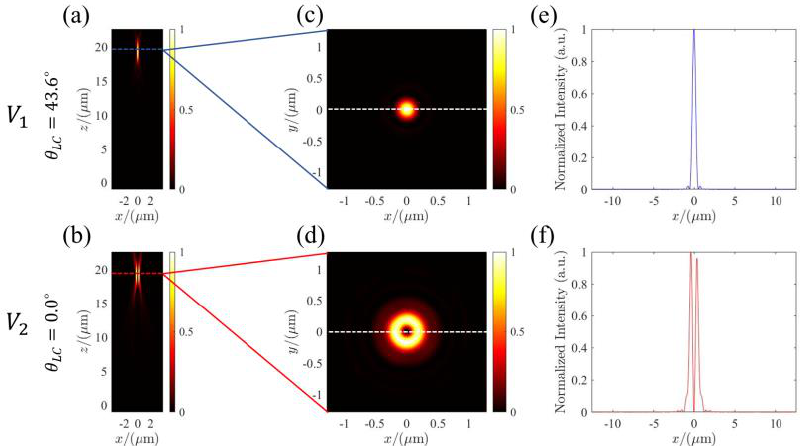
Figure 5. The simulations of the LC-based metalens. ( a , b ) Normalized intensity distribution along the x–z plan for electric-driven voltages V 1 and V 2 , respectively; ( c , d ) the corresponding intensity distributions on focal plane at different voltages; ( e , f ) the corresponding x-cut distributions of the focal